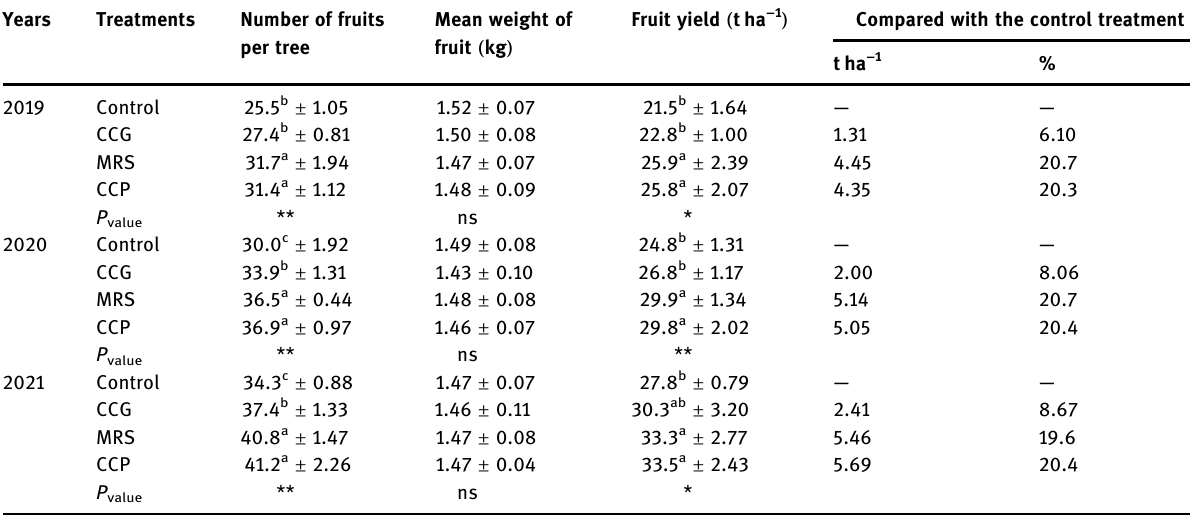
Table 4: Yield component and fruit productivity as a ff ected by soil conservation measures Years